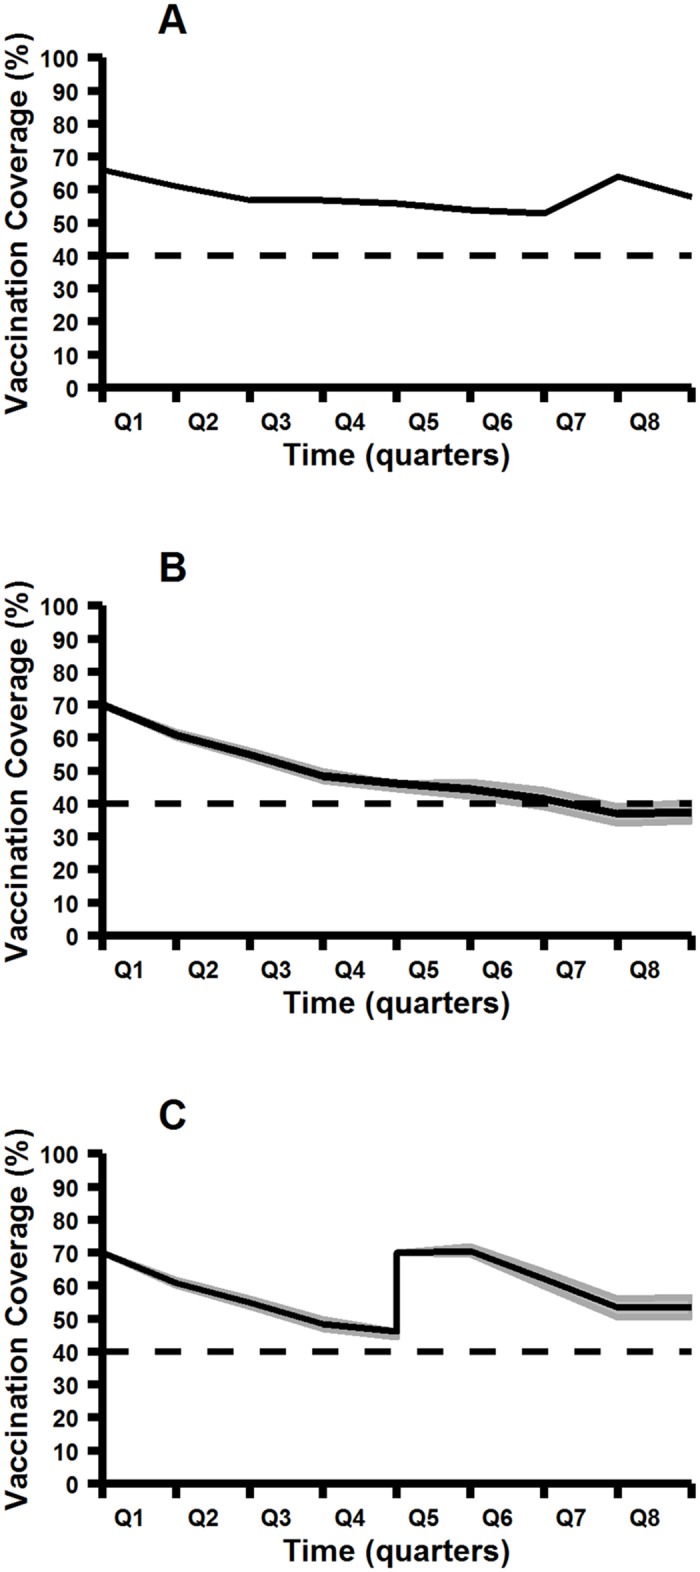
Owner-reported (A) and simulated (B, C) rabies vaccination coverage in owned dogs in the demographic surveillance area, from 1st January 2012 to 1st January 2014.Coverage estimates assume a duration of protective immunity of three years following vaccination. Shaded areas represent minimum/maximum coverage based on 1,000 Monte Carlo simulations. Horizontal dashed line shows the theoretical critical vaccination threshold of 40%. A. Owner-reported vaccination coverage. B. Results of a simulated vaccination campaign on 1st January 2012, reaching a randomly-selected 70% of the dog population present on that date. C. Results of simulated vaccination campaigns on 1st January 2012 and on 1st January 2013, reaching a randomly-selected 70% of the dog population present on those dates.